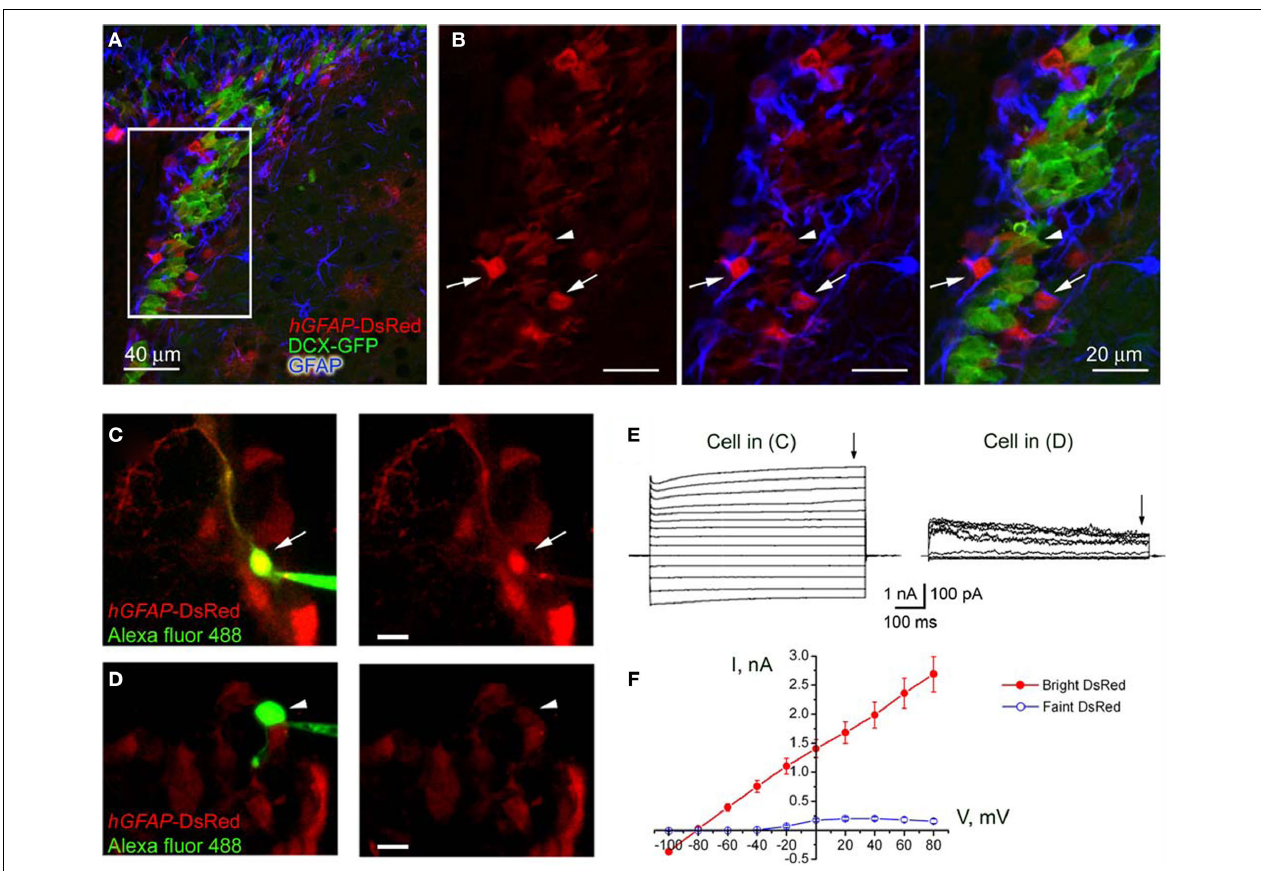
FIGURE 1 | Characterization of hGFAP -DsRed-fl uorescent cells in the SVZ. (A) Confocal images (one optical section) of GFAP immunostaining (blue) in the SVZ contained in a section from a hGFAP -DsRed/ DCX -GFP mouse (P30). (B) Higher power photographs of the staining shown in the white square in (A). The arrows point to GFAP-positive DsRed-fl uorescent cells while the arrowhead points to GFAP-negative, GFP-fl uorescent neuroblasts. (C and D) Photographs of Alexa fl uor 488-fi lled bright (C) and faint (D) red cells during patch clamp